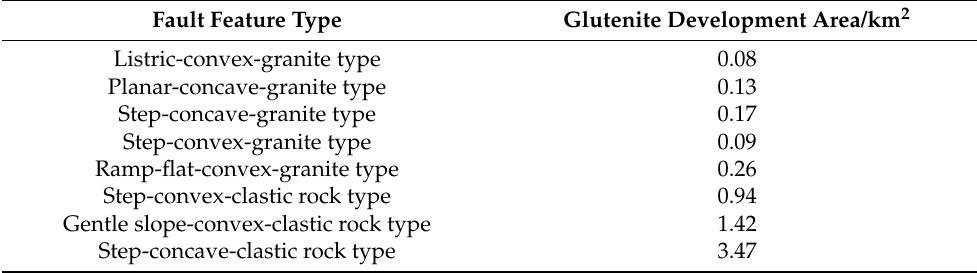
Table 6. Fault characteristics and development area of glutenite in the Guojuzi